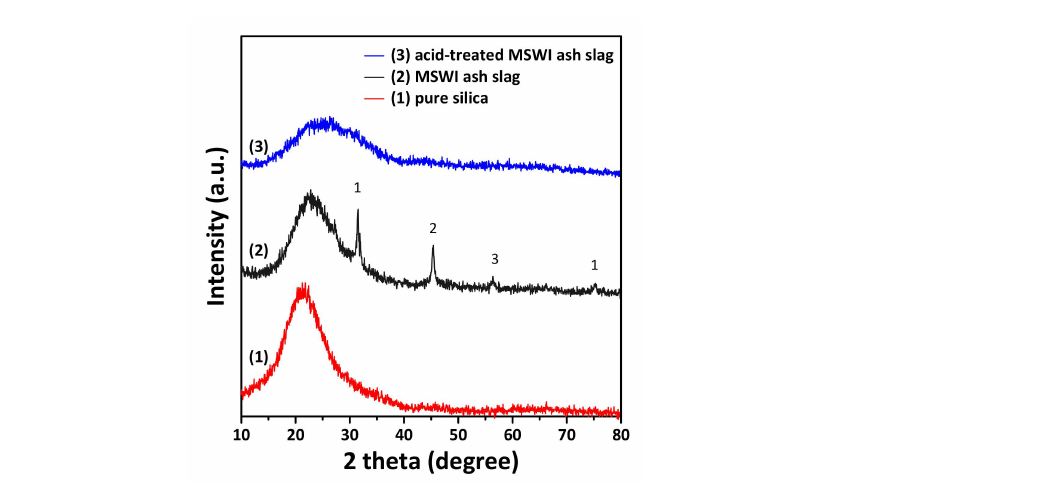
Figure 1. XRD patterns of MSWI ash slag used as the starting material, treated MSWI ash slag ob- tained after acid treatment, and pure silica (for comparison): (1) gehlenite (Ca 2 Al 2 SiO 7 ), (2) magnetite (Fe 3 O 4 ) and (3) hematite (Fe 2 O 3 ).